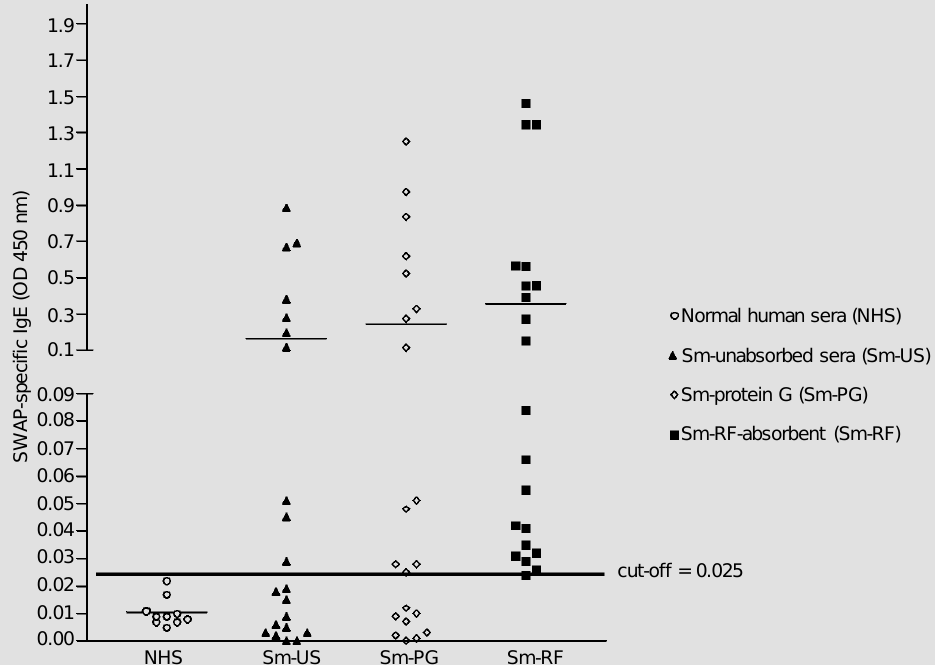
Figure 1 - Detection of specific IgE antibodies anti- S. mansoni (Sm) by ELISA with unabsorbed sera and sera treated with pro- tein G or RF-absorbent from 21 S. mansoni patients. The cut-off is the mean ± 3 SD of 10 sera from healthy